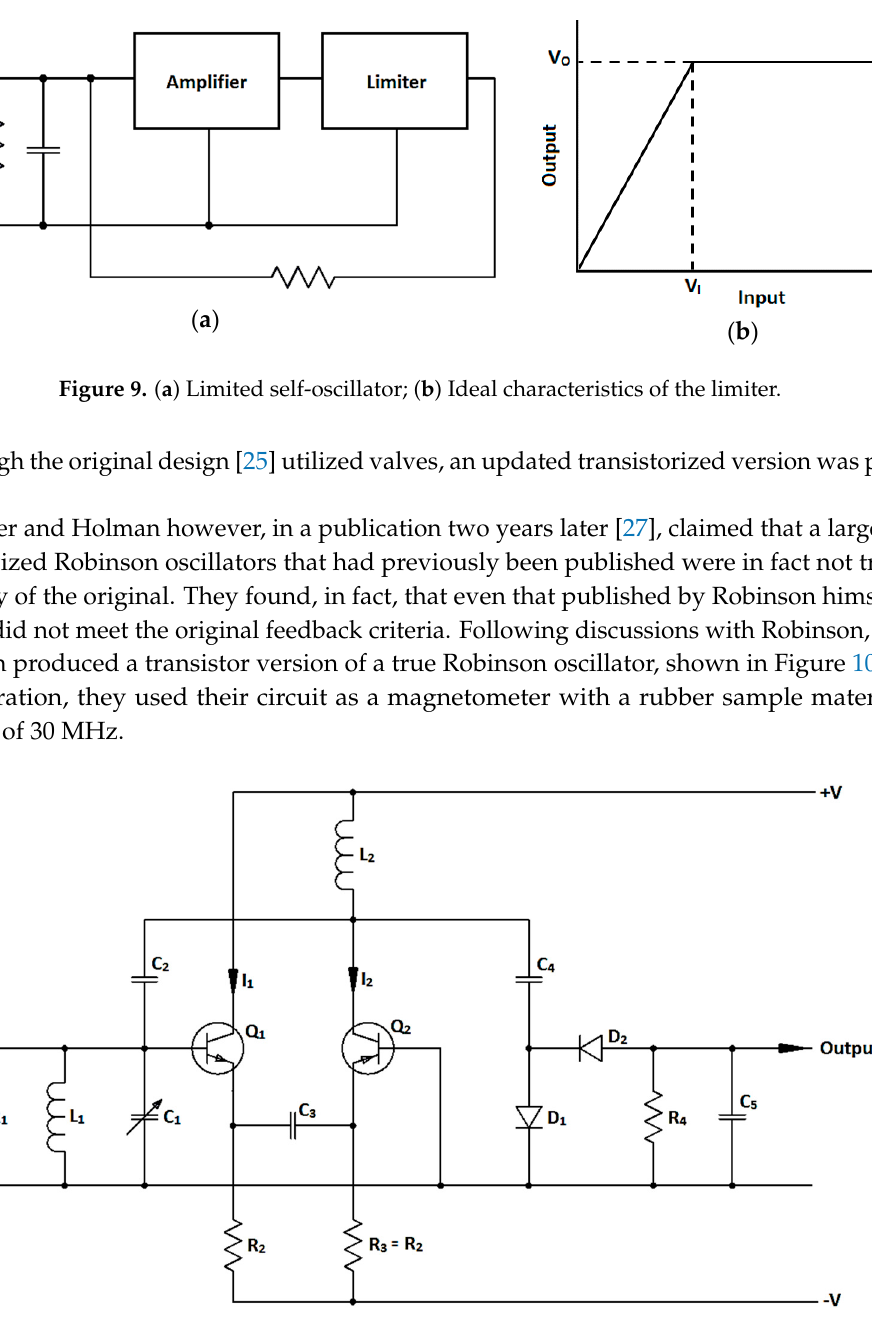
Figure 10. A true transistorized Robinson oscillator.